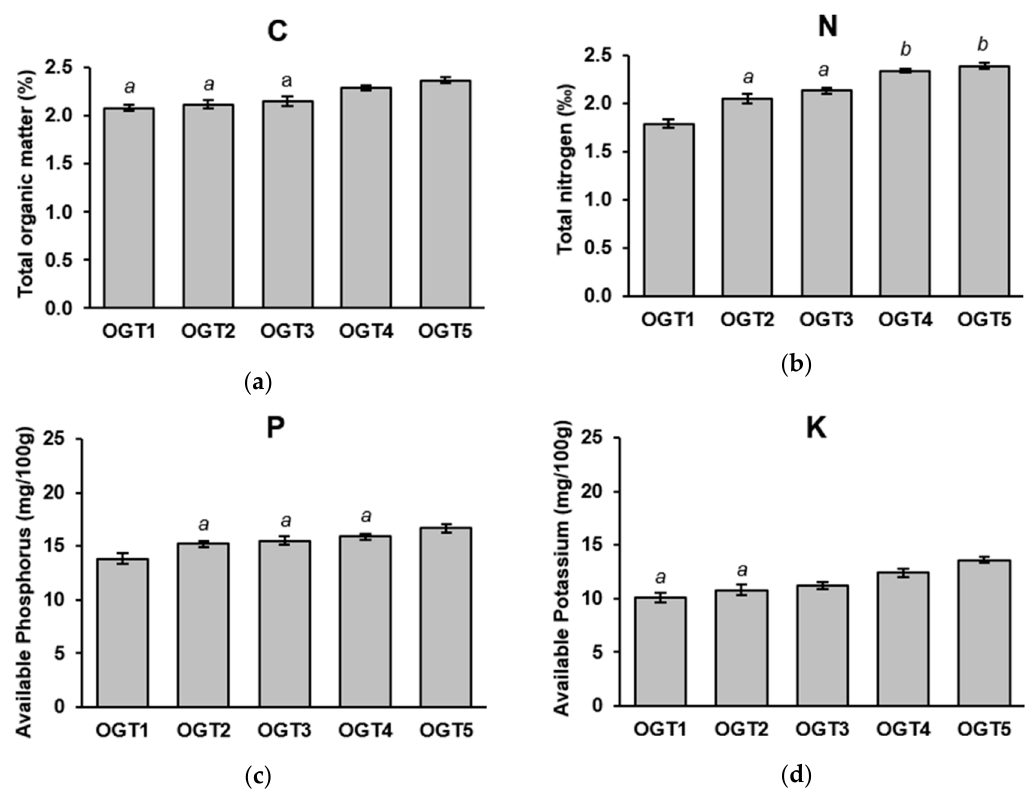
Figure 3. The contents of total organic matter ( a ), total nitrogen ( b ), available phosphorus ( c ) and available potassium ( d ) in the soil at the 4th cultivating year by organic treatments. OGT, organic treatment. Bars show means ± SD. Bars with the same letters are not statistically di ff erent based on the least significant di ff erence at p < 0.05.